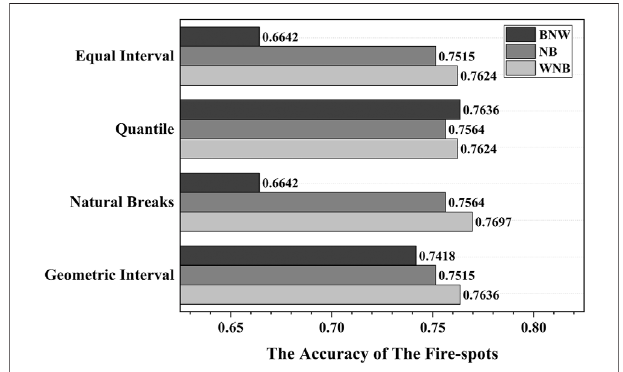
FIGURE 10 | The accuracy comparison of the four grading methods.